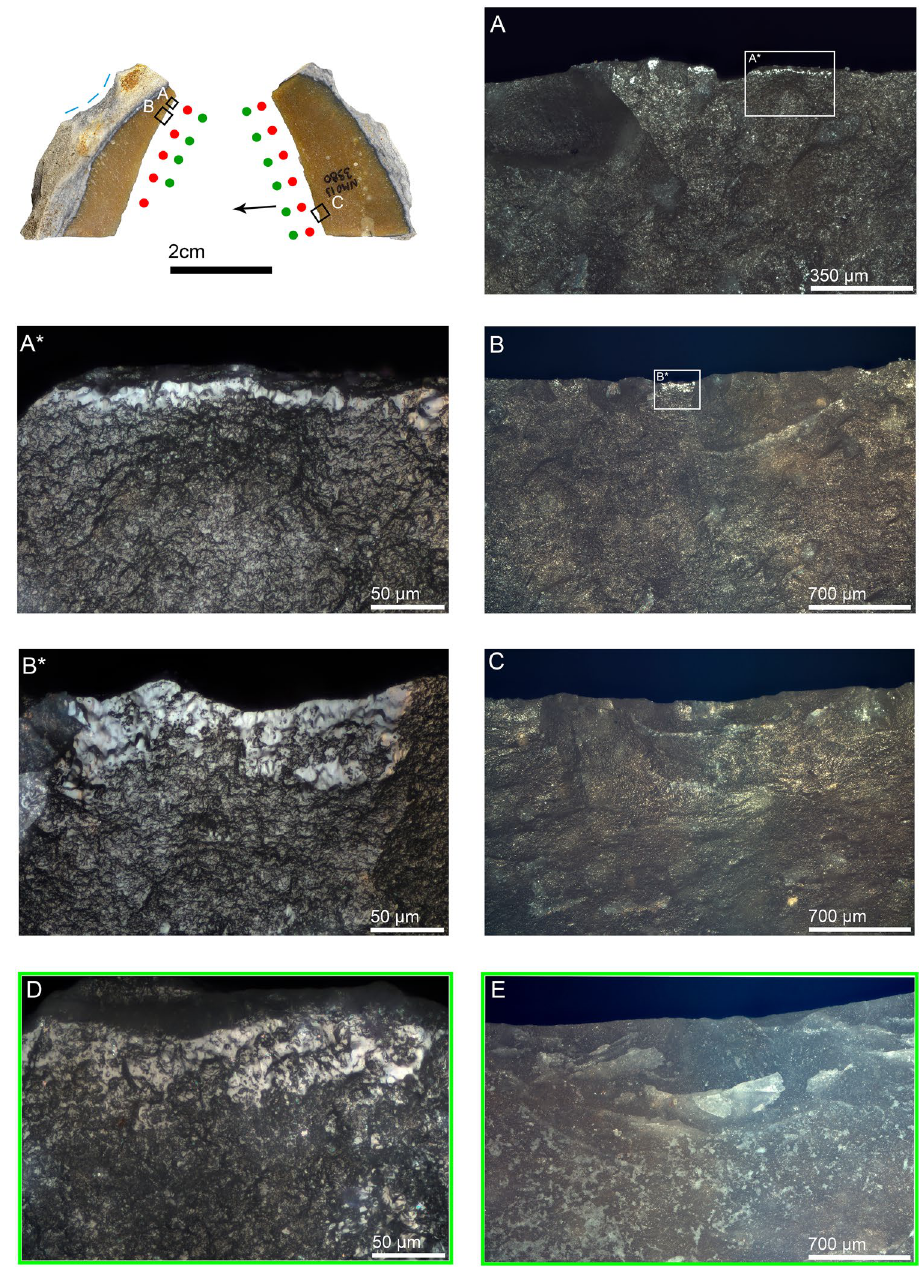
Figure 4. Naturally backed knife NMO13 3980 interpreted as an antler-scraping tool. ( A ) step-terminated macro and micro scars on the dorsal distal left edge with smooth polish restricted to the outer edge on elevated areas between scars, 100 ×; ( A* ) close-up of the previous picture in which the smooth texture and wavy topography of polish are appreciable, as well as transversal linear ripples indicating tool-use direction, 500 ×; ( B ) step-terminated trapezoidal scars associated with polish on the elevated areas between scars on the dorsal distal left edge, 50 ×; ( B* ) close-up of the previous picture showing well-developed polish with a smooth texture and wavy topography, 500 ×; ( C ) overlapped scalar scars showing fissured terminations on the ventral proximal right edge, 50 ×; ( D ) smooth-wavy polish on the mesial dorsal right edge of the experimental tool NMO- EXP50-A, used for scraping dry roe deer antler, 860 strokes, 10 min, 500 ×; ( E ) same experimental tool showing overlapped scalar scars with fissured terminations on the ventral distal right edge, 50 ×. The blue dashed line on the dorsal cortical back of the tool indicates